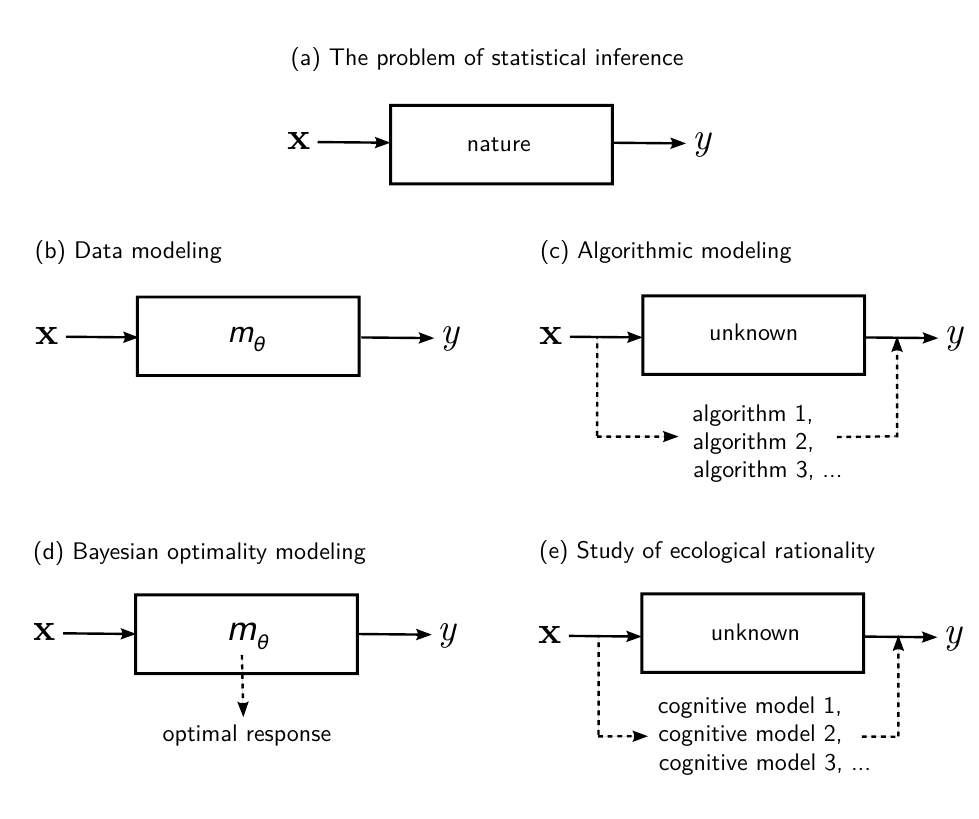
Figure 3 How should the problem of statistical inference be formulated? We start with observations of an unknown functional relationship between input vectors x (the independent variables) and output y (the dependent variable) determined by some aspect of nature, shown in (a). Following Breiman (2001), the statistical culture of data modeling views the conjecture of a stochastic model y = m θ ( x ) of nature’s black box an essential step in statistical inference, shown in (b). Rather than attempt to model the contents of nature’s black box, algorithmic modeling is an incremental search for learning algorithms that can, to varying degrees, accurately predict the input-output relationship, shown in (c). Bayesian optimality modeling conducts data modeling in order to define an optimal response (d), while the study of ecological rationality conducts algorithmic modeling and interprets predictive models as potential cognitive models, shown in (e). Diagrams (a-c) adapted from Breiman